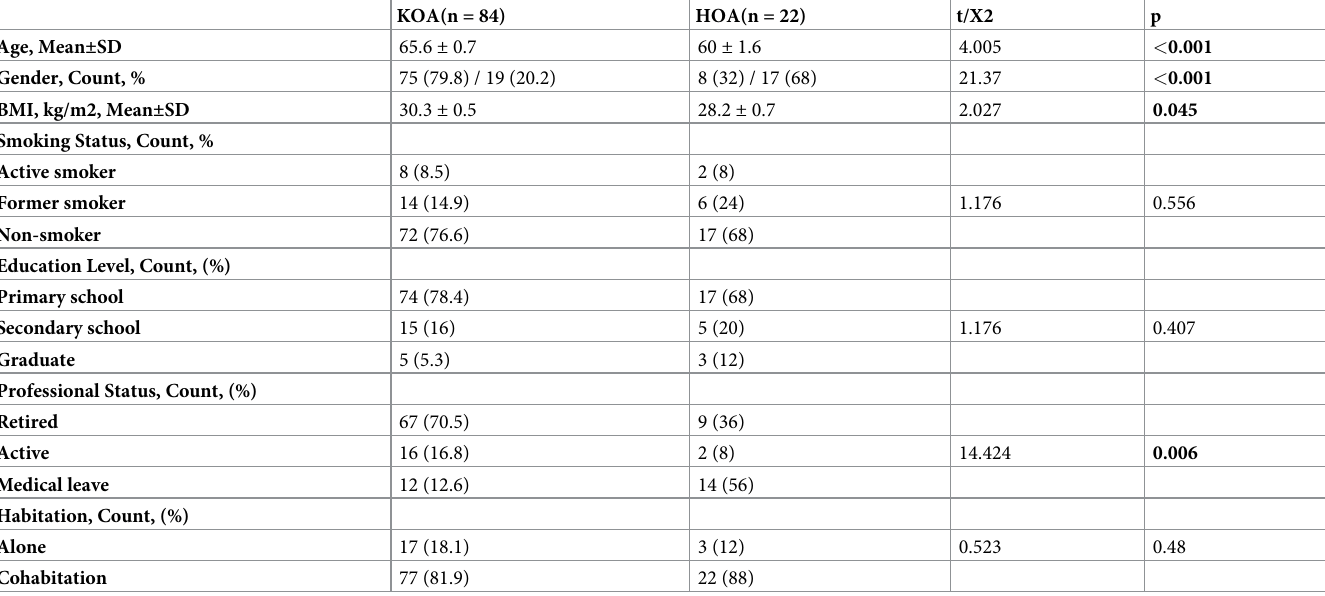
Table 1. Demographic characteristics of KOA and HOA